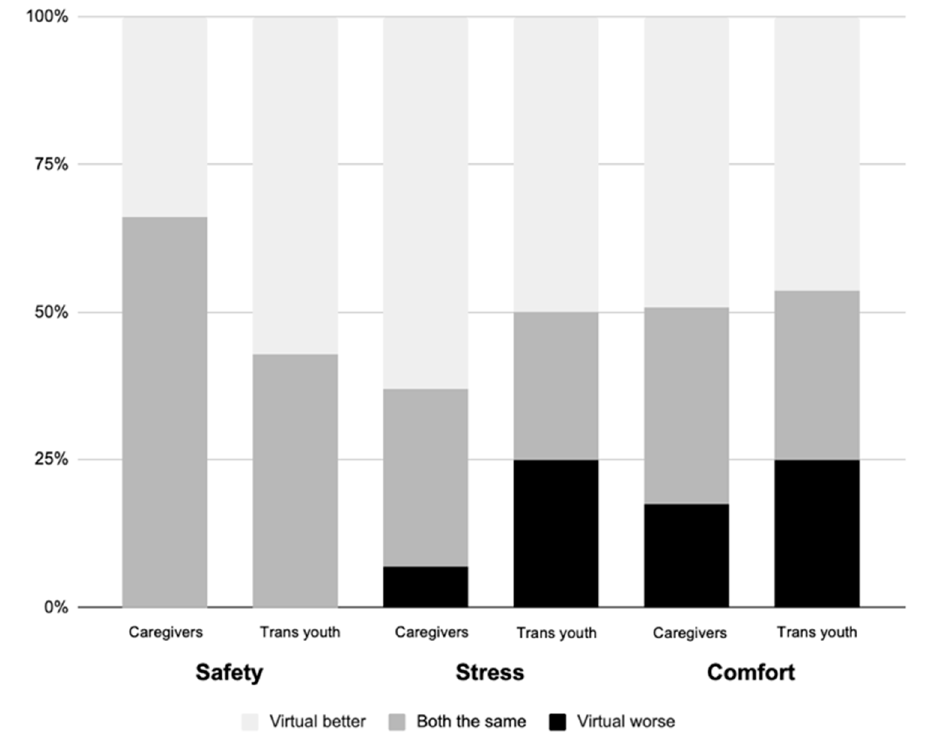
Figure 2. Safety, stress, and comfort of virtual visits: perceptions of caregivers and trans youth. Table 3. Association between patient characteristics and difficulty building a relationship with their provider on a virtual visit and desire to continue virtual care: multivariable regression